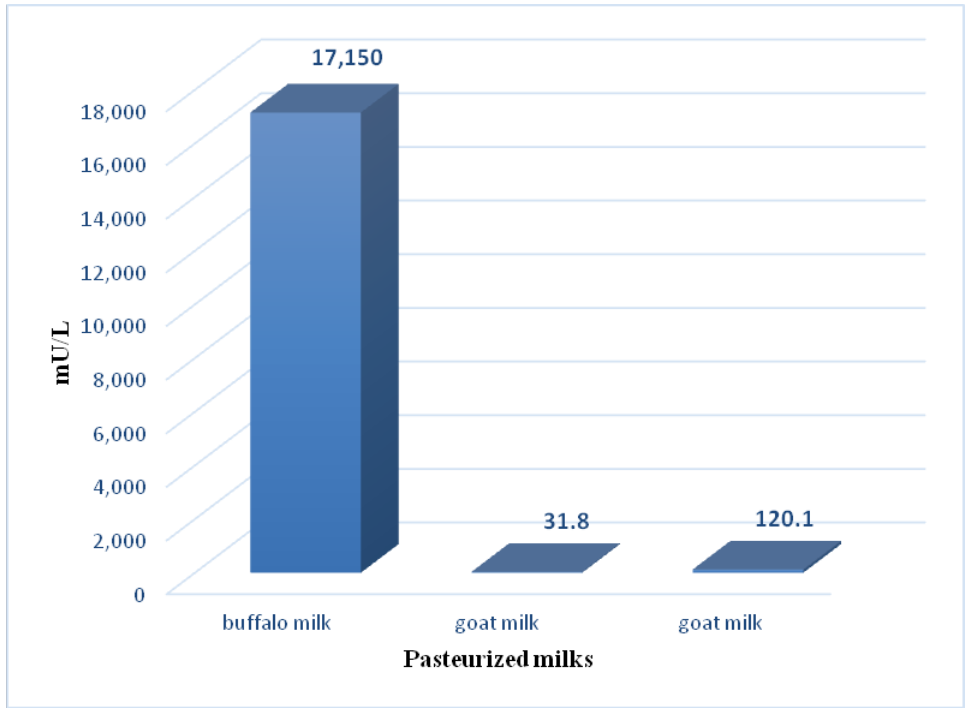
Figure 4. Means of ALP activities in non-cow pasteurized milks [22,29,33]. The available data on ALP in raw and pasteurized sheep milk vary between studies.